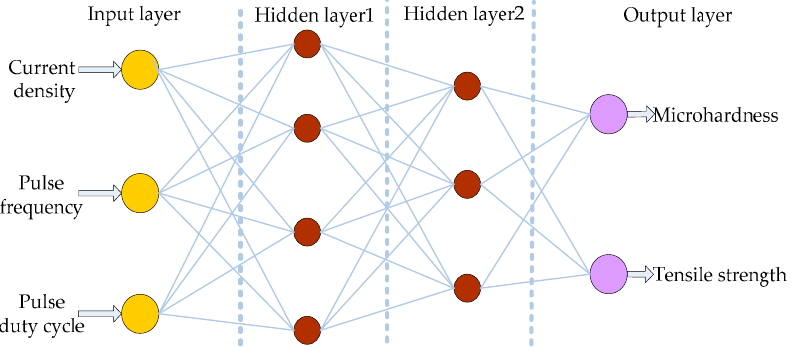
Figure 3. Double hidden layer network structure.